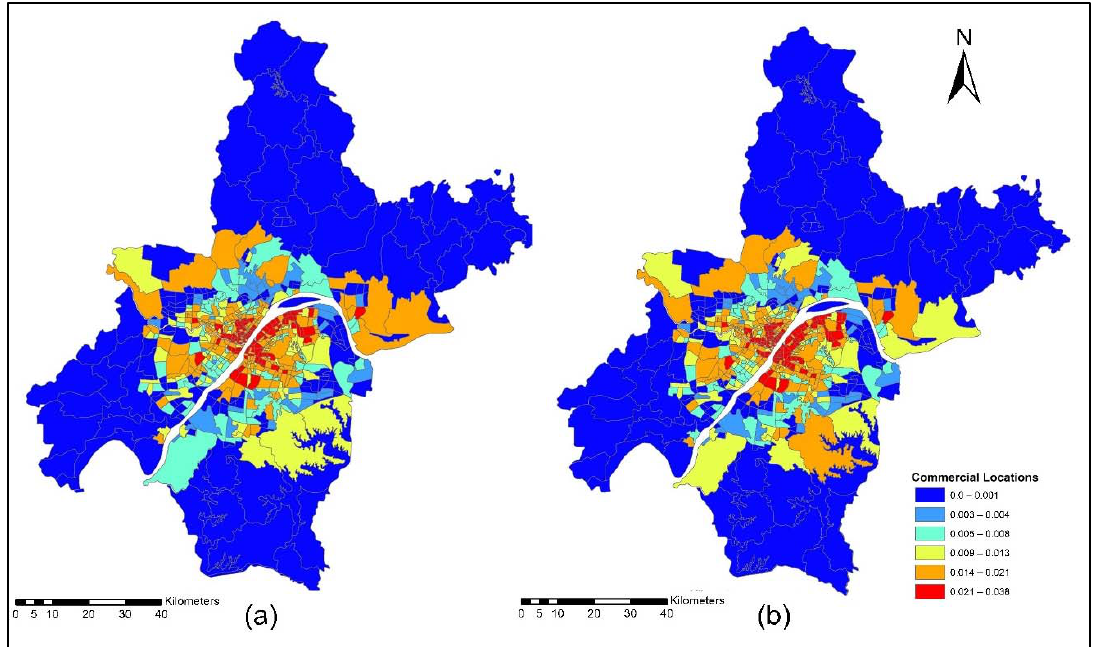
Figure 20. ( a , b ) ISE-estimated commercial locations: ( a ) during evening peak for the year 2012; ( b ) during evening peak for the year 2015.